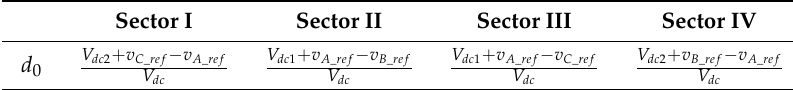
Table 3. Duty ratios of the equivalent zero voltage